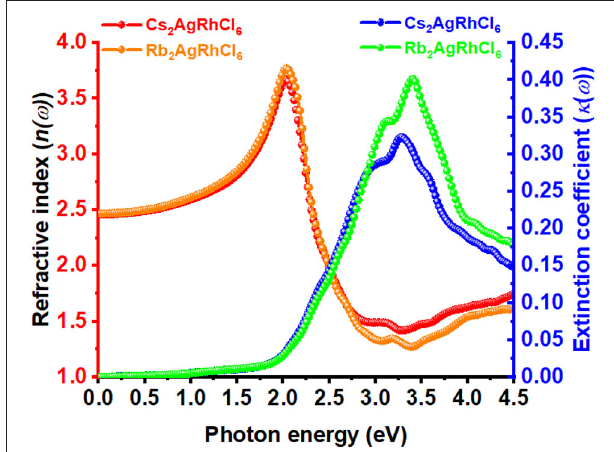
FIGURE 6 | The dependence of the real and imaginary parts of the complex refractive index for Cs 2 AgRhCl 6 and Rb 2 AgRhCl 6 . Although the corresponding spectra of A 2 AgRhCl 6 (A K, Na, Li) were of similar nature, they are not = shown to avoid the complexity of the